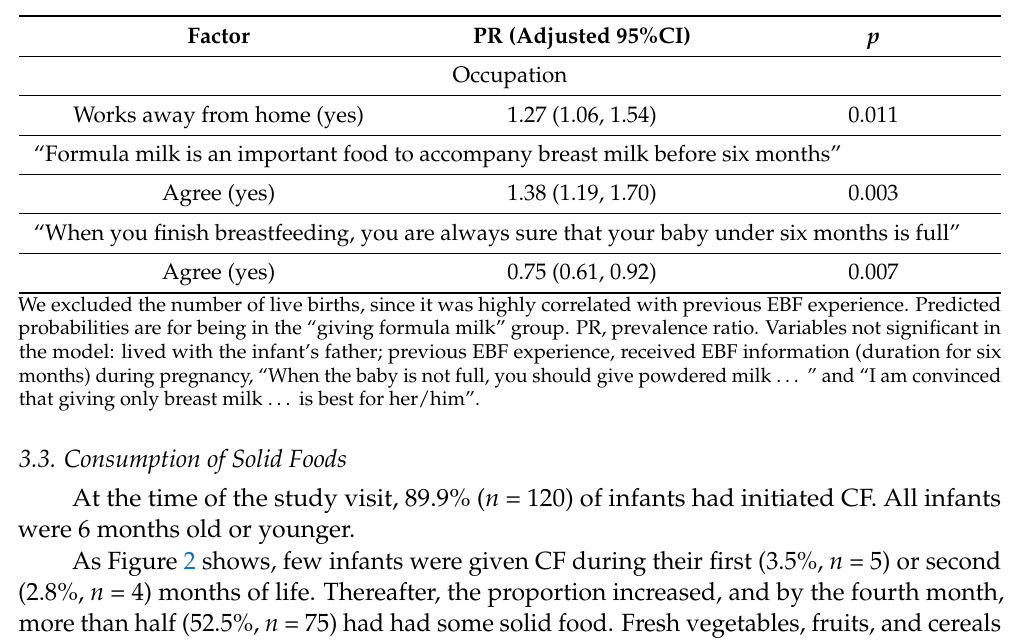
Table 2. Factors related to giving formula milk.